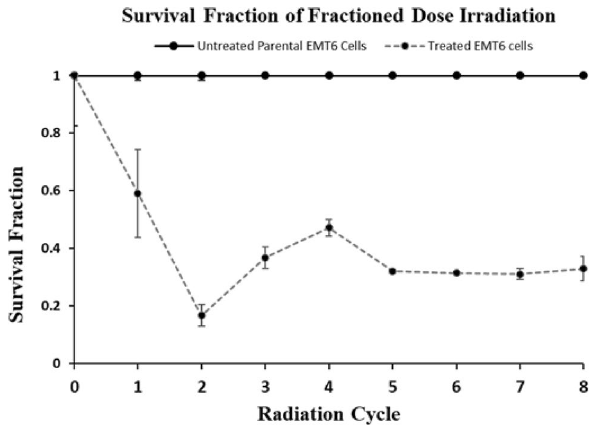
Figure 1. Survival fraction of EMT6 cells after fractionated dose irradiation. The survival fractions of untreated and treated parental EMT6 cells are presented by the respective solid and dotted lines. (Data n = 3, mean ± s.d) (The result presented was partially published 18